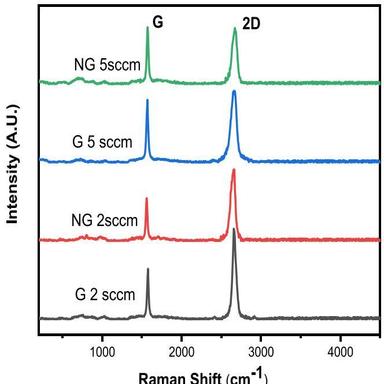
Raman spectra of graphene and nitrogen-doped graphene in different gas flow rates.